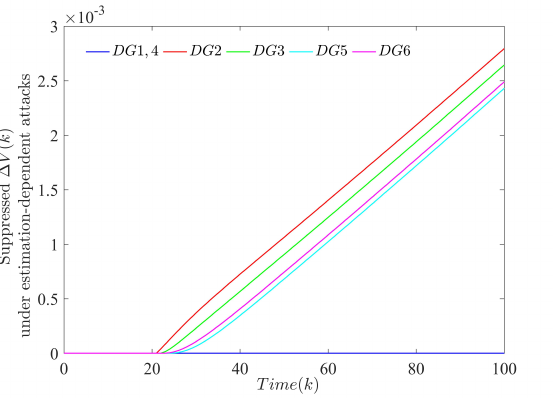
Figure 10. Estimation difference of the DGs using the proposed strategy under the estimation- dependent